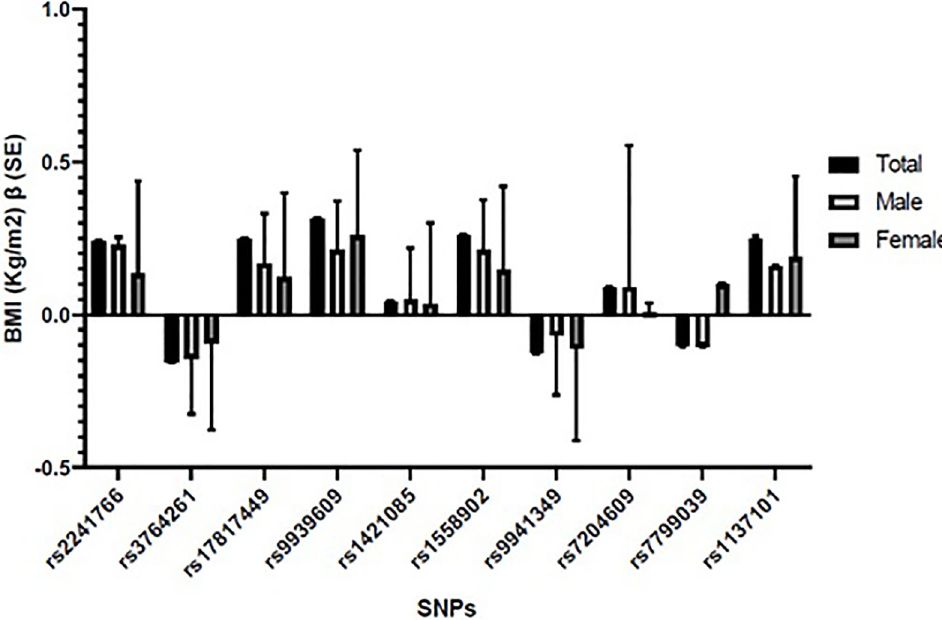
Fig 3. BMI raising risk effect size estimation of minor alleles. The BMI raising risk effect size of all genetic variants are presented as β -coefficients (SE) in total and gender based (Male vs female) population cohort obtained by linear regression analysis. The positive β -coefficient values represent an increase in BMI (Kg/m 2 ) while a negative value showed a decrease in BMI (Kg/m 2 ) for each copy of the minor allele of a